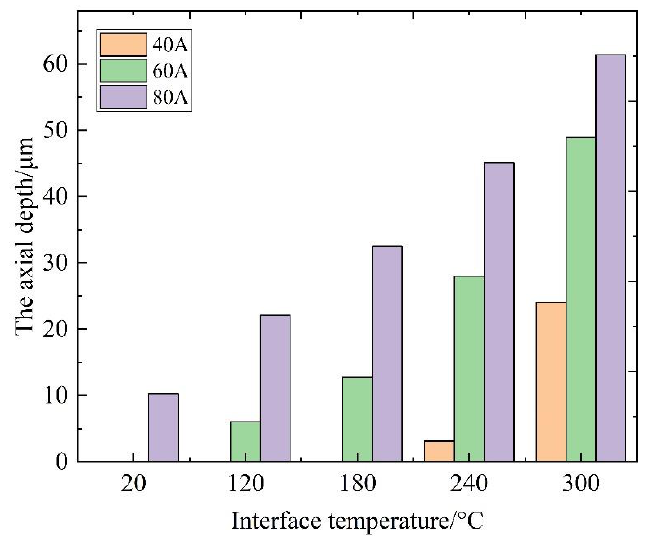
Figure 11. The axial depth of the contact spot reaches the softening temperature of copper at differ- ent interface